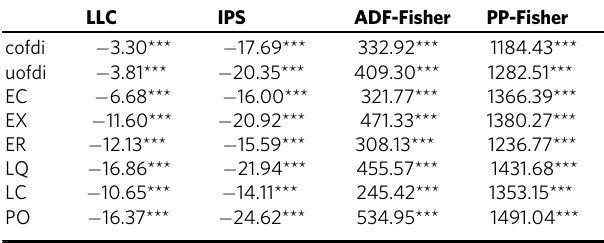
Table 9 VECM estimates analysis results (USA). Table 6 Panel unit root test results.